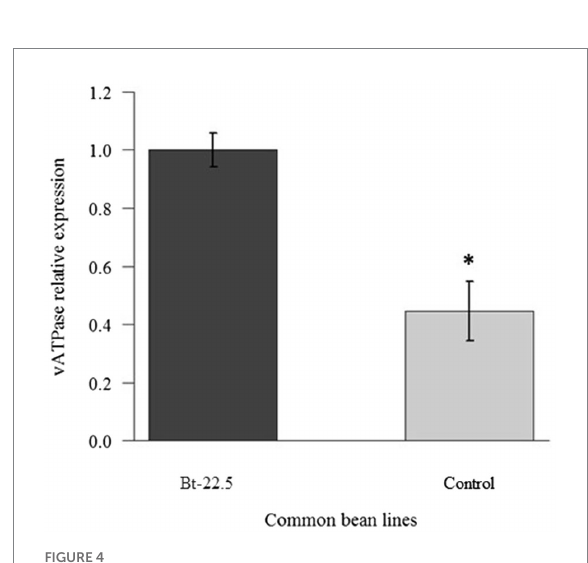
FIGURE 4 Relative expression of the transcripts of the vATPase gene in Bemisia tabaci adults after 48 h of feeding on the transgenic common bean plants, determined by qRT-PCR ( * p < 0.05, n =